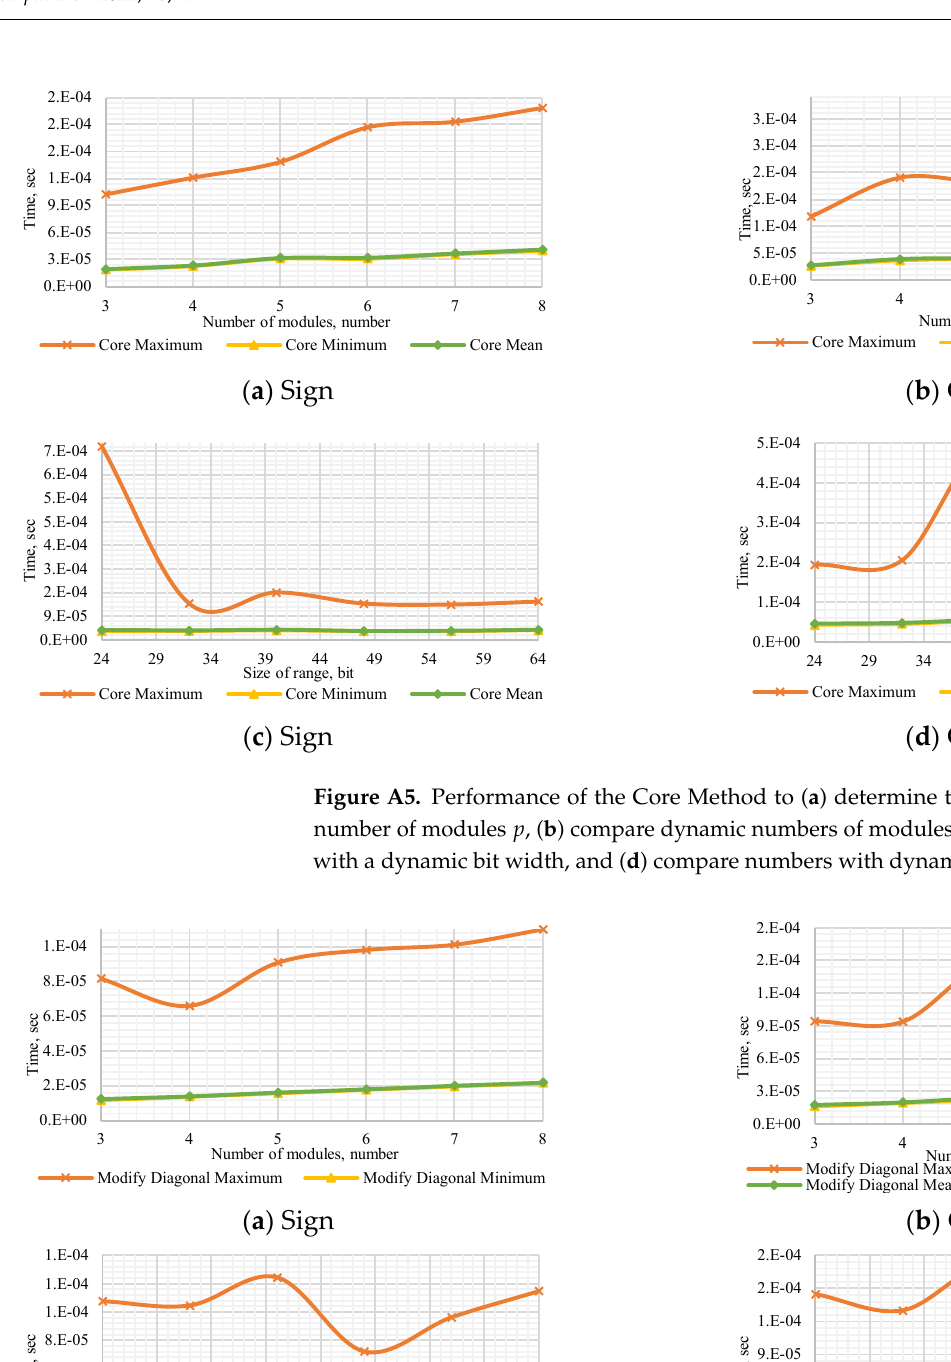
Figure A4. Performance of the Diagonal Method to ( a ) determine the number’s sign with a dynamic